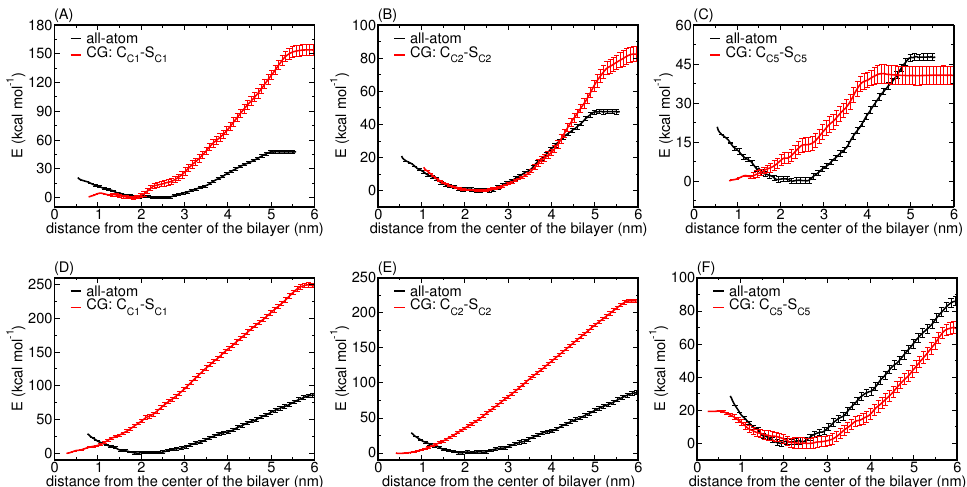
Figure 2. PMFs (red curves) calculated for the insertion of a CG NP of size 3 nm (top) and 5 nm (bottom) in the lipid bilayer composed of DPPC, POPC, DOPC and CHOL in a 5:2:2:1 ratio. Subplots ( A – F ) show CG PMFs for different CG bead types selected in the uniform model, as denoted in the legends. Although shell and core always bear the same bead type in the uniform model, the general notation of the core-shell setup is used for consistency. The shaded region corresponds to the standard deviation calculated over 100 iteration steps using the bootstrapping technique in GROMACS. The reference PMFs (black curves) were determined using constrained AAMD for the considered NP sizes in our previous atomistic study [35], and are only added here to enable a direct visual